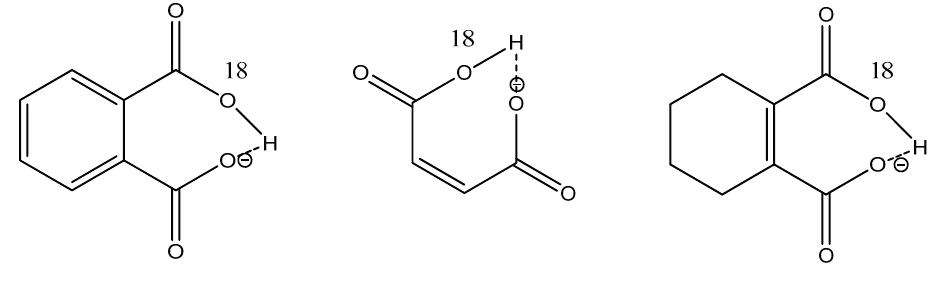
Figure 15. 18 O-labelled